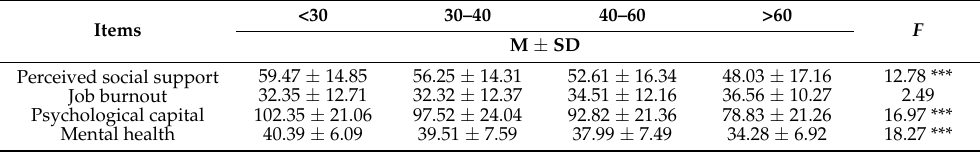
Table 14. Variance analysis on various variables with different daily delivery order